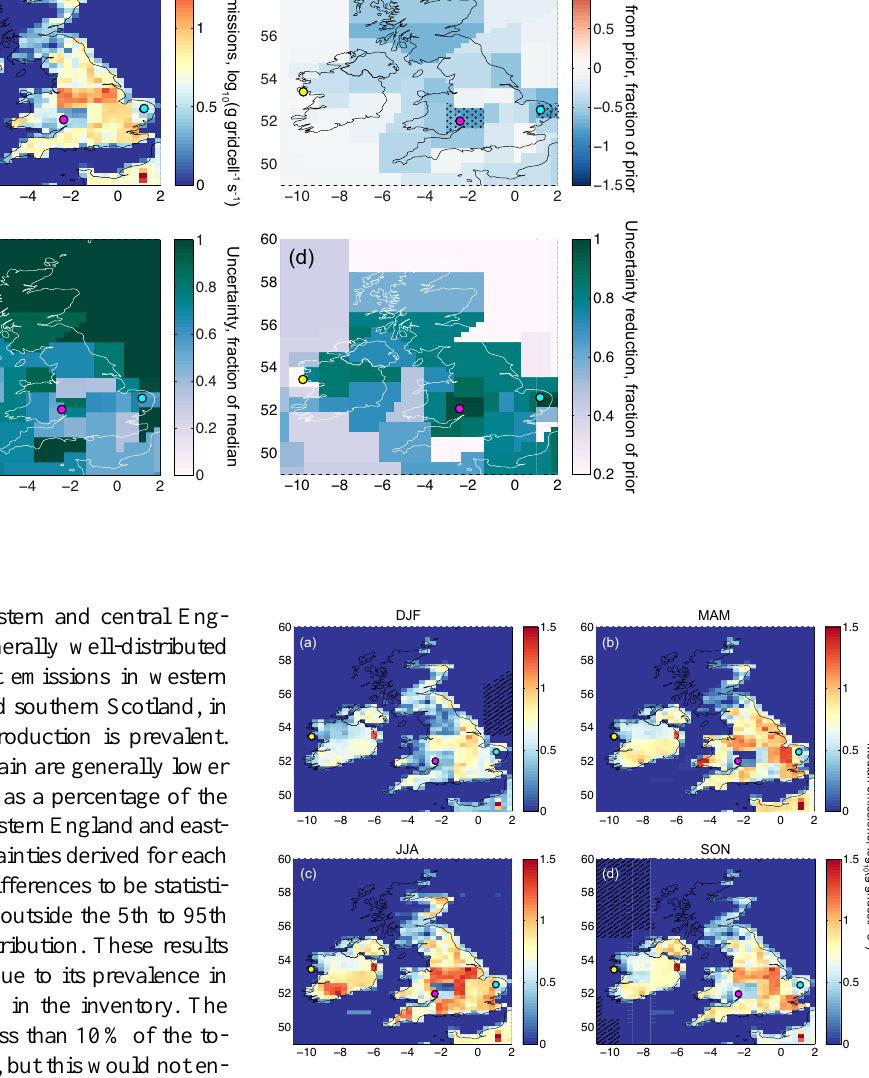
Figure 6. N 2 O emissions by season, shown on a logarithmic scale. Emissions have been disaggregated from the larger regions esti- mated in the inversion using the prior distribution. Regions with hashing correspond to sink regions and are plotted as their abso- lute value. Colored circles show the measurement stations (MHD, yellow; RGL, magenta; TAC,